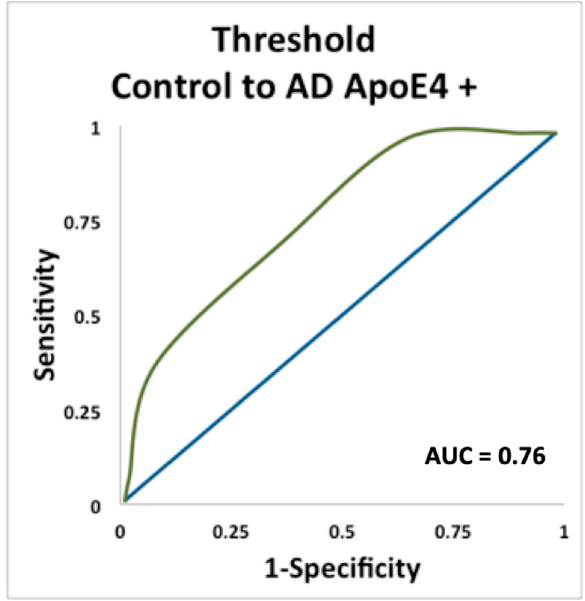
Figure 3. ROC curve plotting sensitivity and specificity for predicting conversion from cognitively normal controls to AD in carriers of the ε 4 allele, using odor threshold.